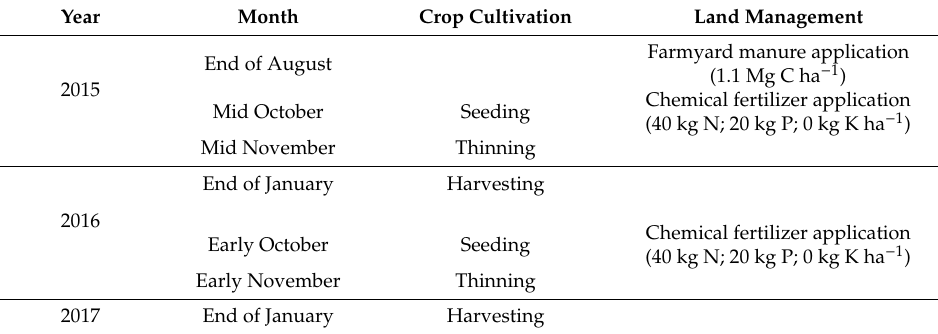
Table 1. Description of the crop cultivation and land management in each experimental